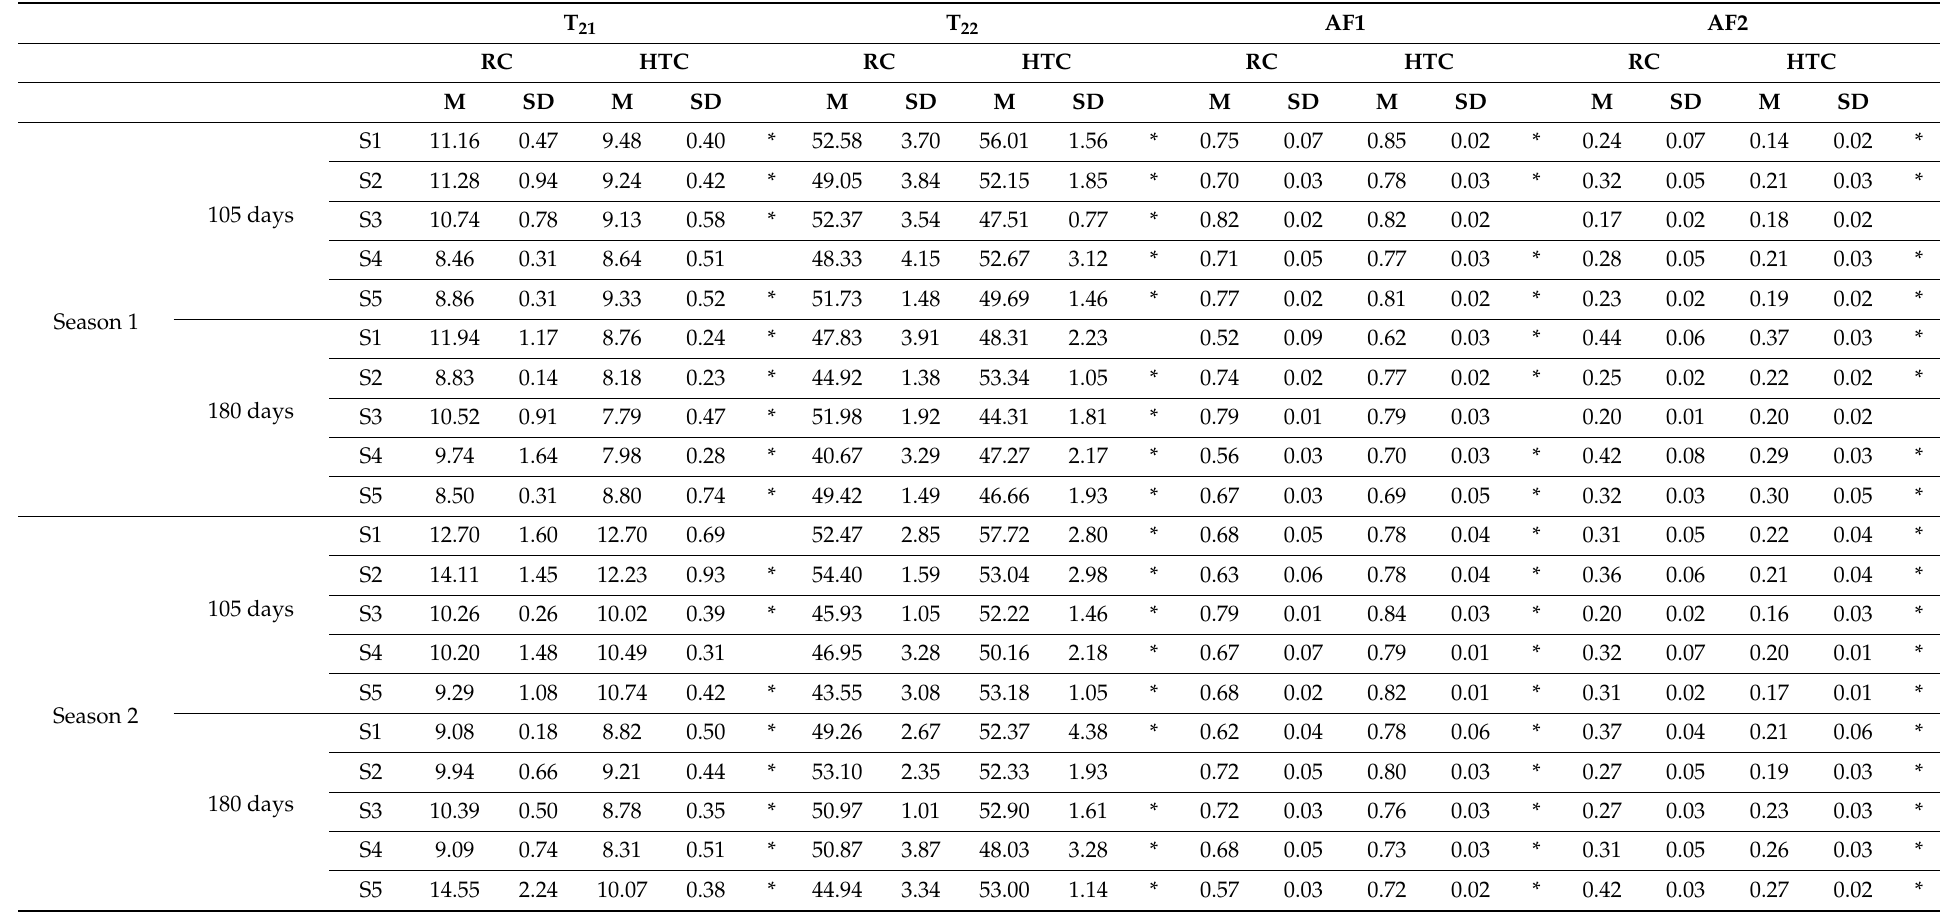
Table 1. T 21 and T 22 values (ms) and corresponding mean area fractions AF1 and AF2 (%) of artisanal FS cheeses produced in Season 1 and Season 2; asterisks (*) in each row indicate significant differences ( t -test, p < 0.05) between RC and HTC parameters (T 21 and T 22 , AF1 and AF2) for each sample (M = Mean; SD = Standard